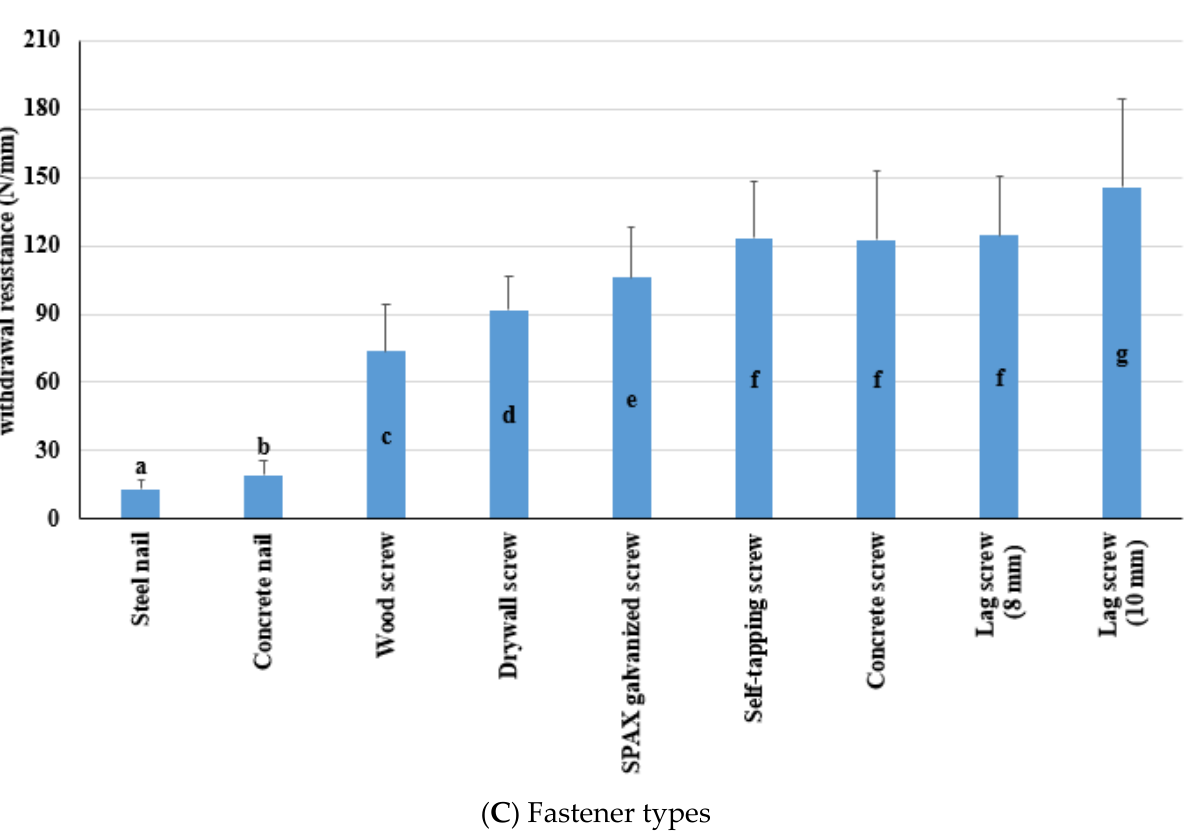
Figure 4. Effects of layer arrangements ( A ), loading directions ( B ), and types of fasteners ( C ) on withdrawal resistance.